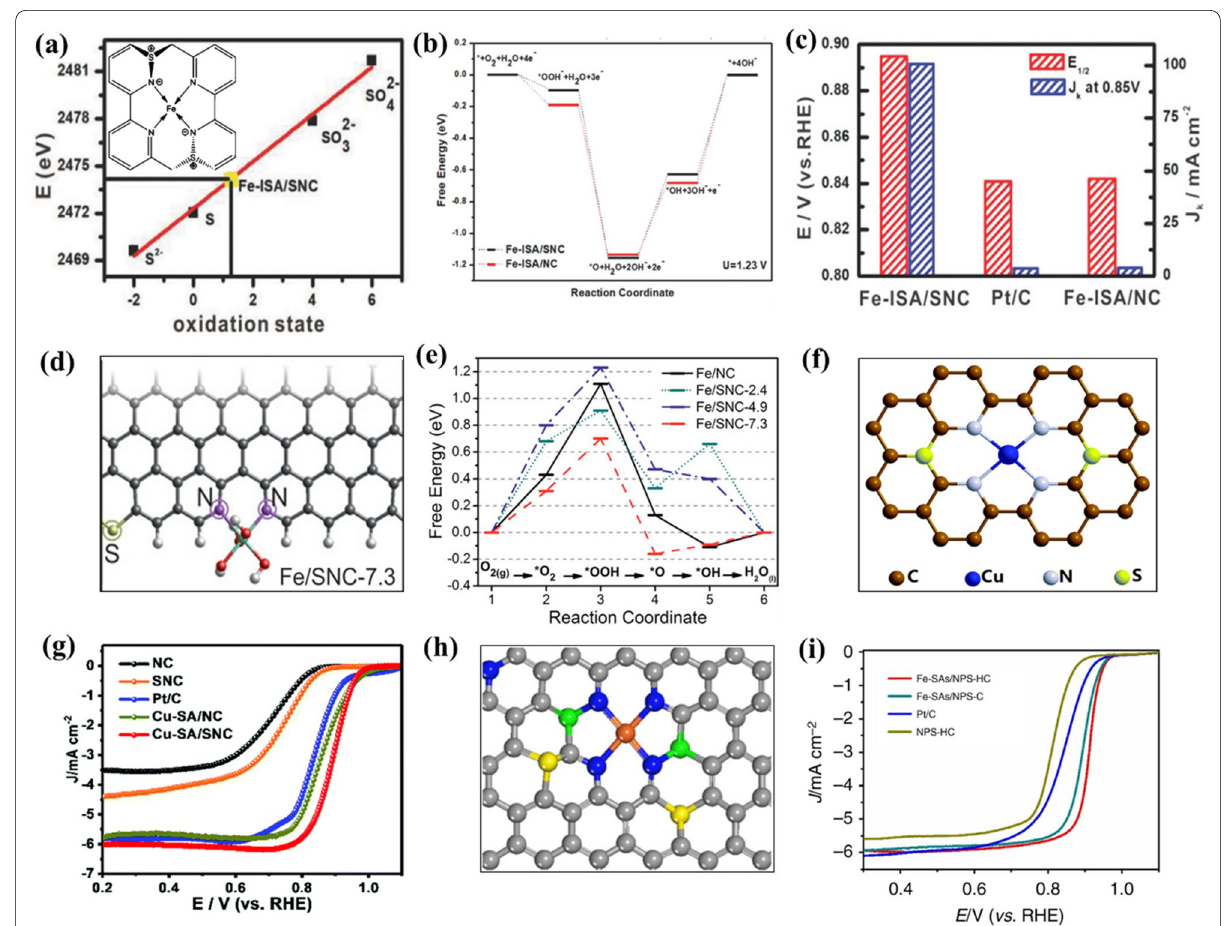
Fig. 8 a Linear fitting curve of oxidation state for Fe‑ISA/SNC and reference materials. The insert is the molecular structure of Fe‑N 4 S 2 active site in Fe‑ISA/SNC. b Free energy diagrams of ORR on Fe‑ISA/SNC and Fe‑ISA/NC. c Comparison of J k at 0.85 V and E 1/2 of Fe‑ISA/SNC, Fe‑ISA/NC, and Pt/C. d Geometric structure of Fe/SNC‑7.3. e Free energy diagram of ORR on Fe/NC and Fe/SNC. f Schematic interfacial model of Cu‑SA/SNC. g LSV curves of Cu‑SA/SNC, Cu‑SA/NC, SNC, NC, and Pt/C catalysts in O 2 ‑saturated 0.1 M KOH solution. h Schematic model of Fe‑SAs/NPS‑HC, Fe (orange), N (blue), P (green), S (yellow) and C (gray). i LSV curves of Fe‑SAs/NPS‑HC, Fe‑SAs/NPS‑C, NPS‑HC, and Pt/C catalysts in O 2 ‑saturated 0.1 M KOH solution. a ‑ c Reproduced with permission from Ref. [119]. Copyright 2018, Wiley‑VCH. d , e Reproduced with permission from Ref. [115].